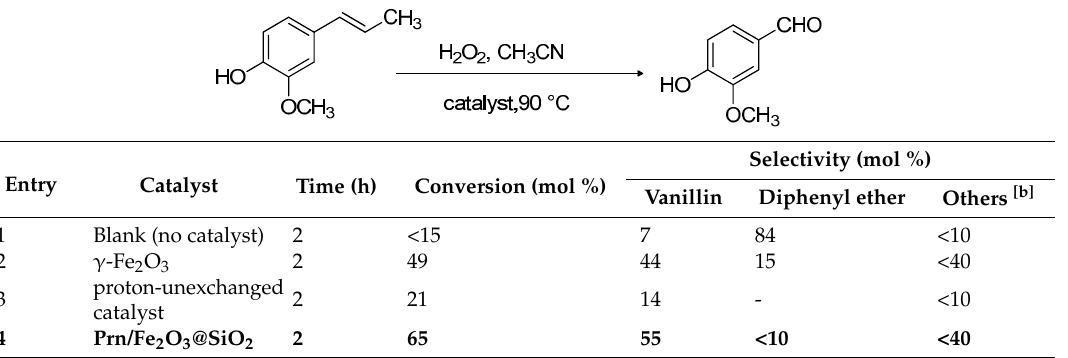
Oligomers and high molecular weight lignin-like compounds were detected as major reaction side products. Table 4. Catalytic oxidation of vanillyl alcohol [a ] . (In bold: best catalytic system).